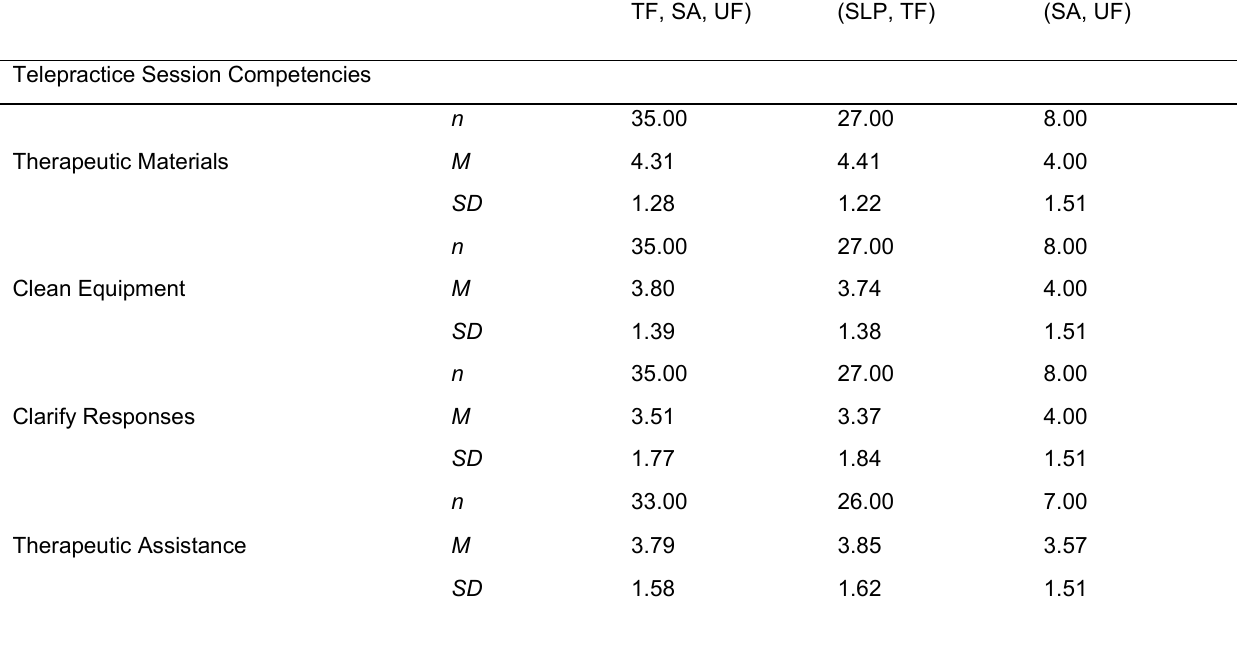
Supplementary Skills Descriptive